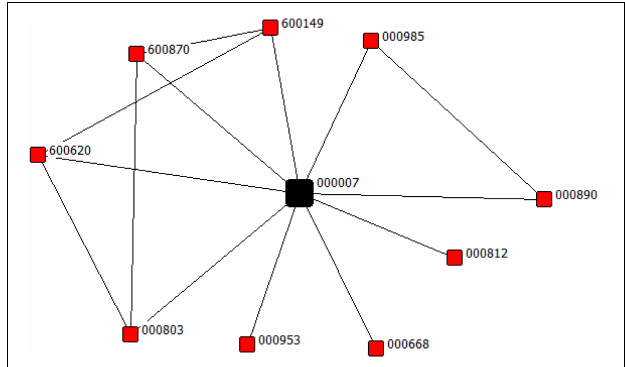
FIGURE 1 | The perceived competition network of focal firm (000007) in